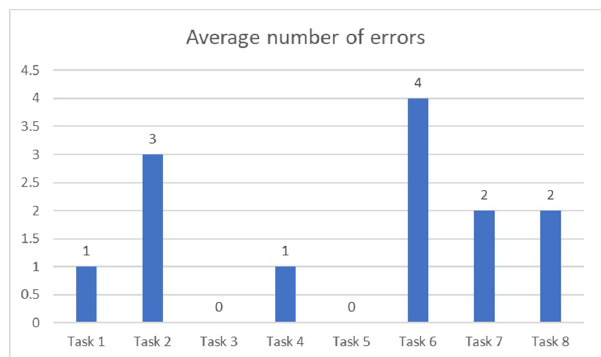
Figure 8. Tasks completion rate.